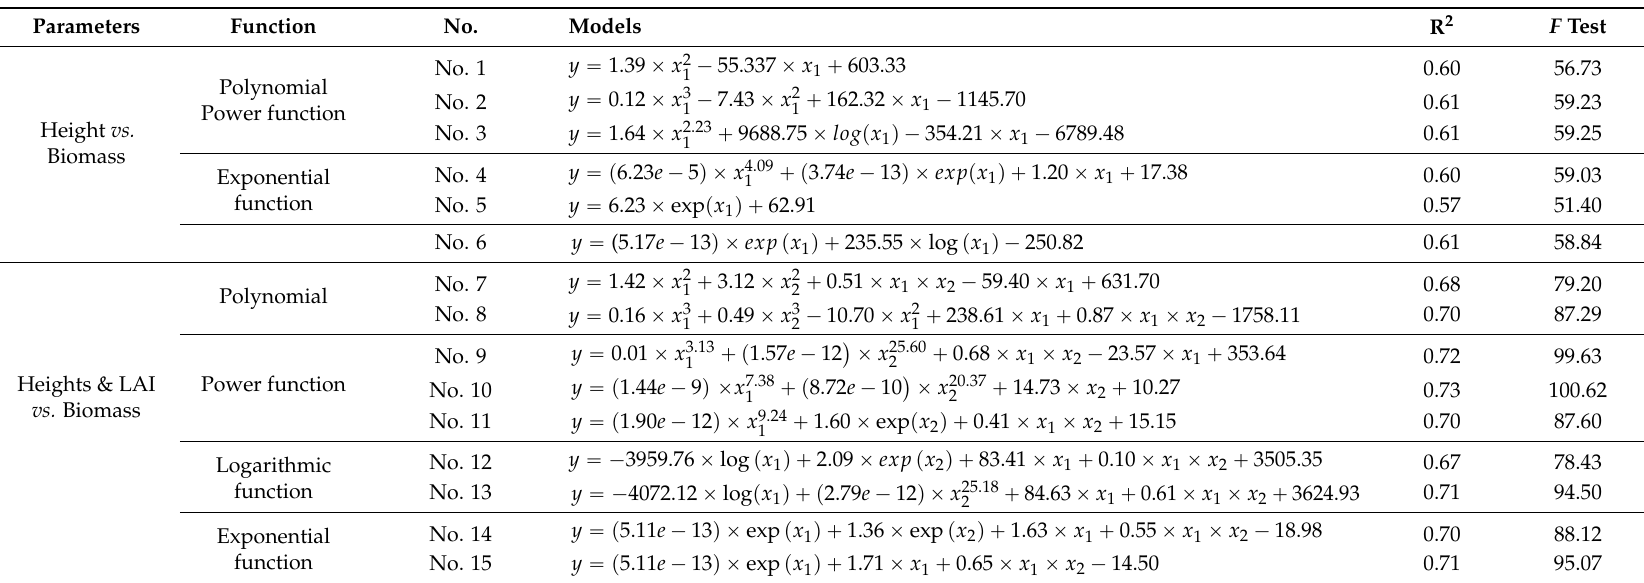
Table 2. Regression models lists (Y represents the biomass. x 1 represents canopy height and x 2 represents LAI.). Parameters